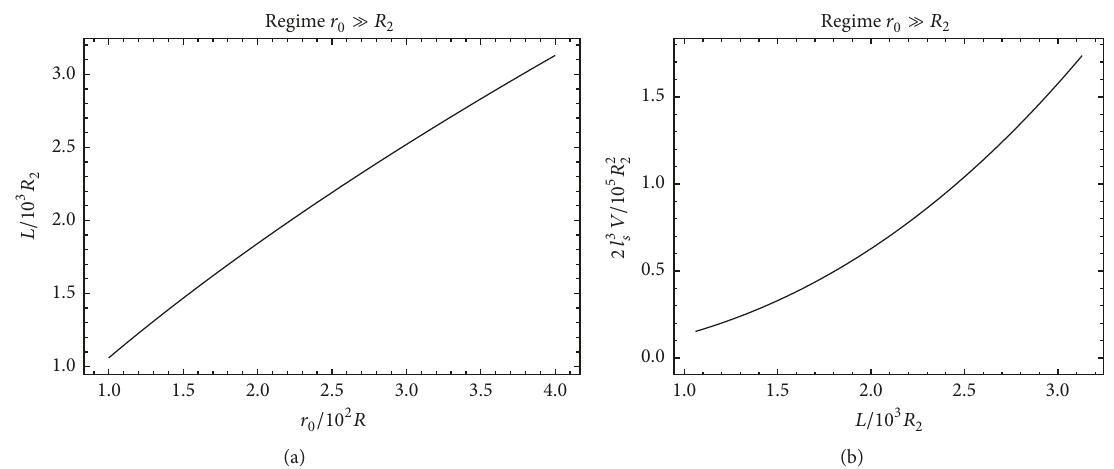
Figure 7: (a) Distance 𝐿/𝑅 2 between quarks in a M2 brane space versus 𝑟 0 /𝑅 2 . (b) Potential 𝑙 3 11 𝑉/𝑅 2 between quarks in a M2 brane space versus 𝐿/𝑅 2 for 𝑟 0 ≫ 𝑅 2 . Here, in both panels 𝑟 1 /𝑅 = 10 4 and 𝑟 0 /𝑅 2 > 10 2 .